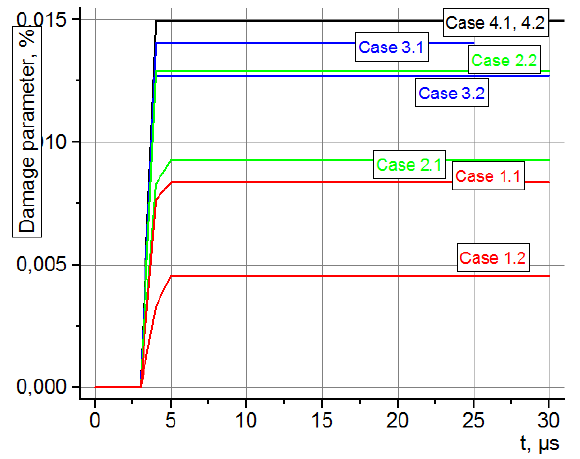
Fig. 9. Hydrostatic pressure vs.